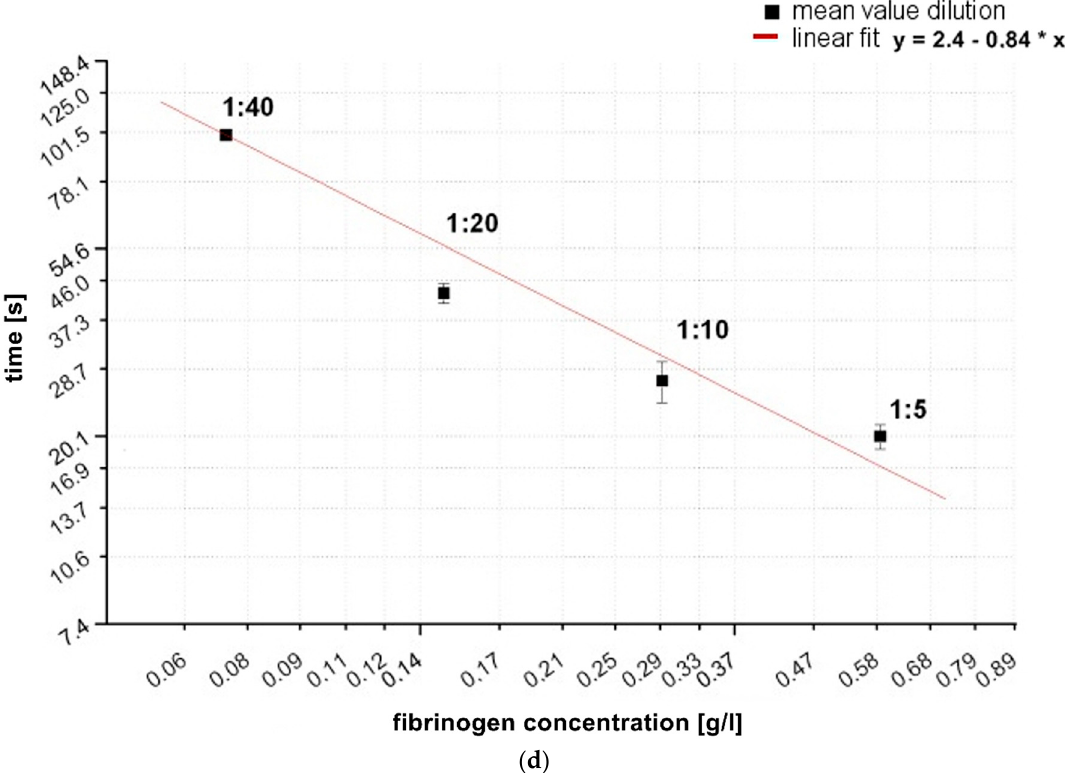
Figure 3. ( a ) Comparison of absolute values of frequency and dissipation changes shown on a double logarithmic scale with reference pool plasma dilutions of 1:5, 1:10, 1:20, 1:40. All quartzes were pre-coated with the correspondent dilution of the calibration measurement. The QCM-D signal changes were determined at t = 900 s after starting coagulation by adding thrombin. n = 6 measurements per dilution. Shapiro-Wilk-Test for testing of normal distribution and ANOVA for variance analysis. Significance is indicated with asterisks as follows: * = significant with p ≤ 0.05, ** = very significant with p ≤ 0.01, *** = highly significant with p ≤ 0.001. Grey dotted line indicates the different slopes s of linear fit curves of the dissipation (s = 789) and frequency signal (s = 2284) concerning signal change per g/L. ( b ) Generated calibration curve of fQCM by different dilutions; ( c ) Generated calibration curve of dQCM by different dilutions. ( d ) Generated calibration curve of Merlin coagulometer by different dilutions. Logarithmic x - and y -axis display of fibrinogen concentration and signal changes in ( b – d ); red lines illustrate linear fit of mean values per dilution.